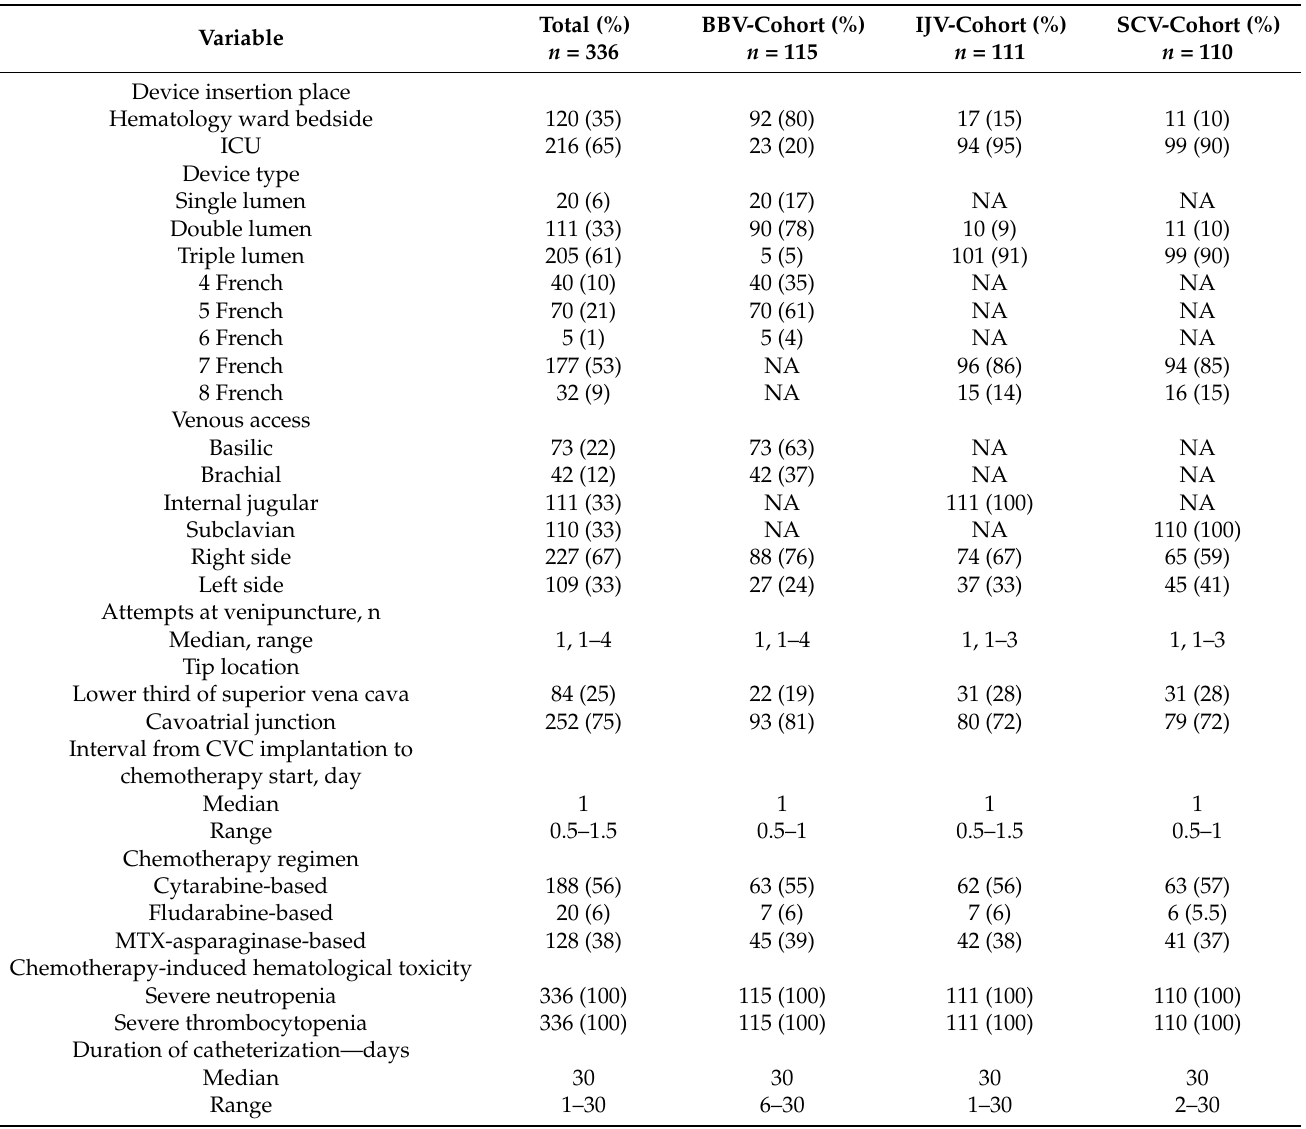
Table 2. Characteristics of implanted catheters and their